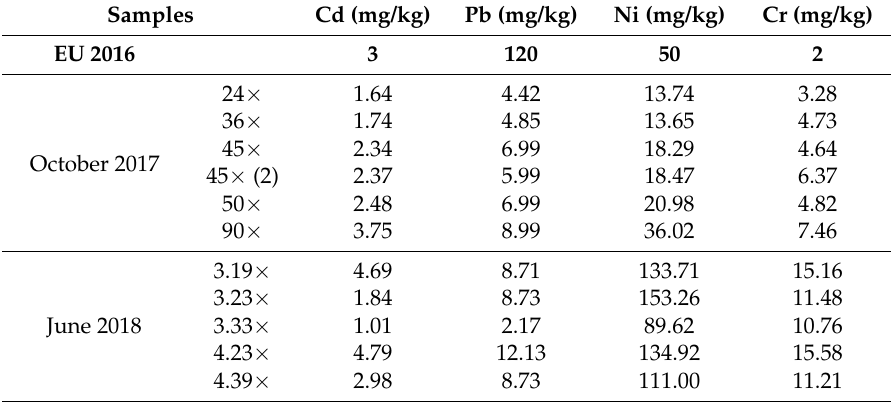
Table 5. Concentration of heavy metals in the concentrated leachates.